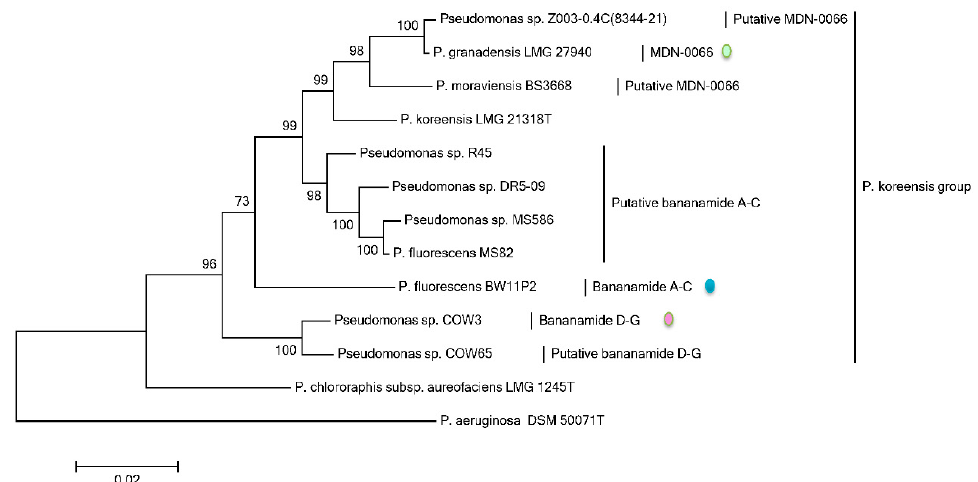
Figure 6. Multi-locus sequence phylogenetic analysis of rpoD, rpoB, 16S rDNA and gyrB partial sequences of bananamide-producing Pseudomonas strains. The tree was constructed with MEGA6 using the Maximum Likelihood Method with 1000 bootstrap replicates. Only bootstrap values above 70% are indicated. The CLPs with the coloured spheres have been fully characterized. indicated. The CLPs with the coloured spheres have been fully